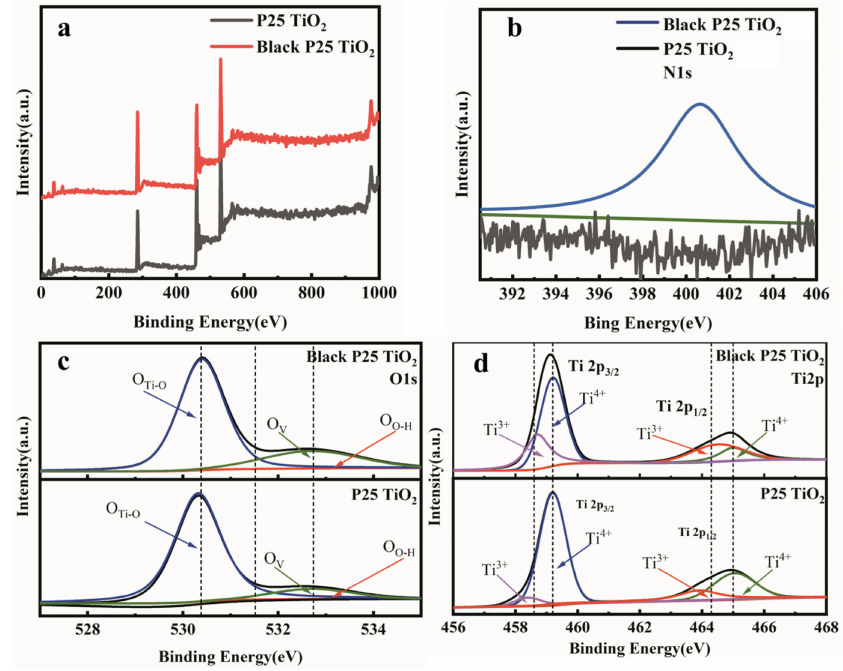
Figure 3. ( a ) XPS survey of P25 TiO 2 and black P25 TiO 2 ; ( b ) N1s XPS spectra of P25 TiO 2 and black P25 TiO 2 ; ( c ) O1s XPS spectra of P25 TiO 2 and black P25 TiO 2 ; ( d ) Ti2p XPS spectra of P25 TiO 2 and black P25 TiO 2